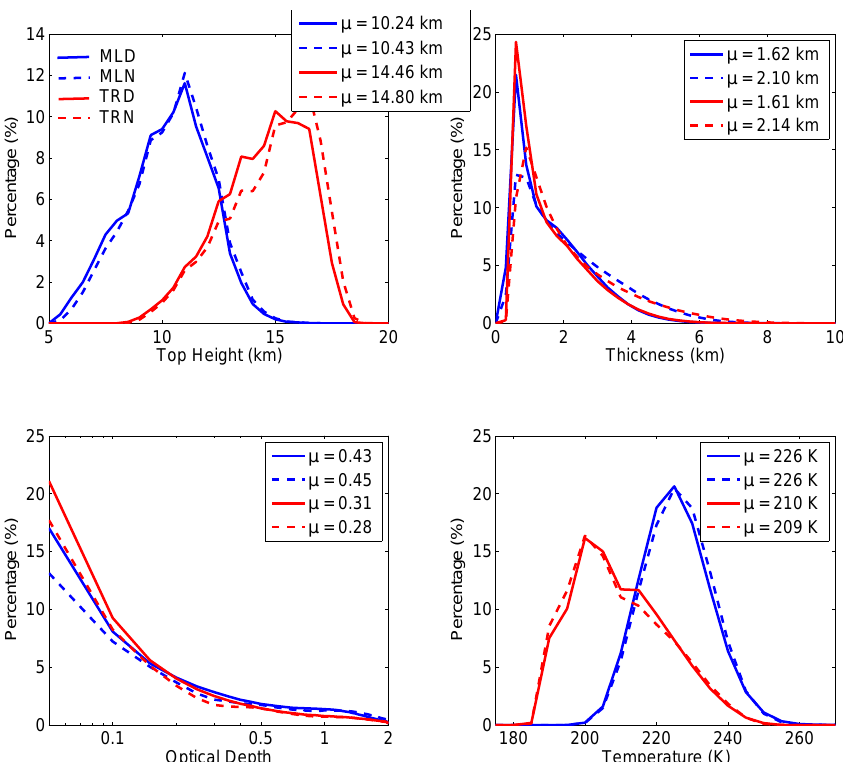
Fig. 1. Top height (upper left panel), geometrical thickness (upper right), optical depth (lower left) and midlayer temperature (lower right) distributions for the cirrus clouds selected in the Reduced Database (see Table 1). Midlatitude data are in blue and tropics in red. Dashed lines are for nighttime cirrus clouds (MLN and TRN) while solid lines are used for daytime (MLD and TRD). For each distribution the mean value µ is also reported. Lower left panel is in Logarithmic-Linear scale